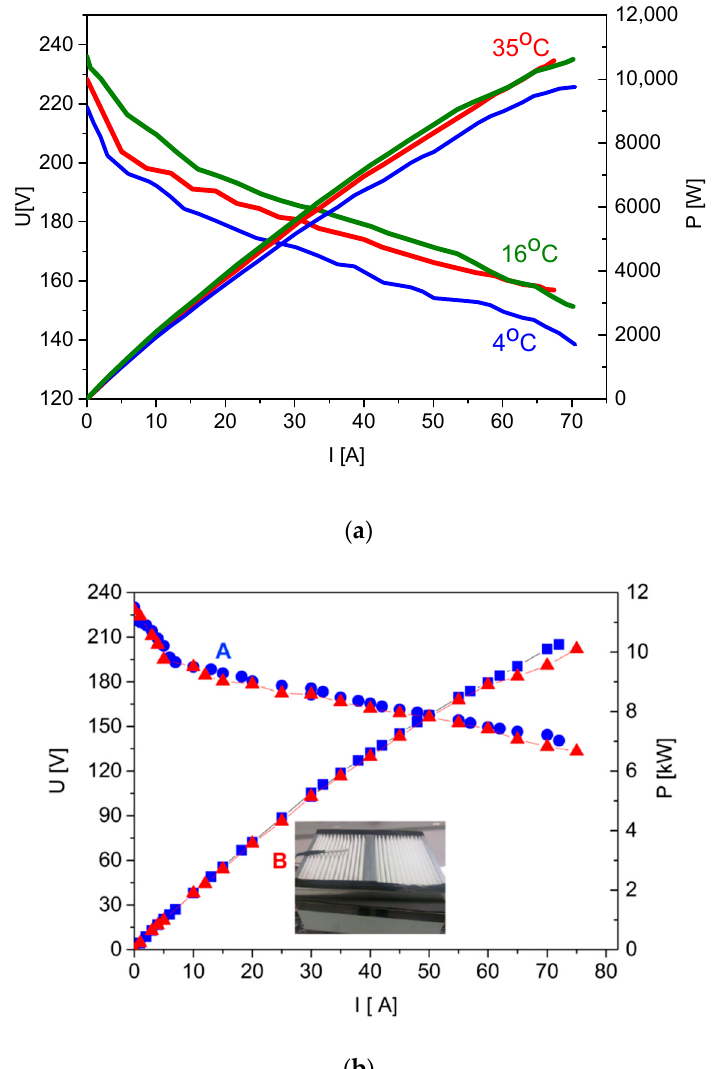
Figure 9. ( a ) Voltage U-current I or power P-current I dependencies recorded for a 10 kW PEMFC stack in different ambient conditions. The numbers above the curves denote the temperature (°C) of the performed measurements. ( b ) The U-I and P-I curves recorded for the PEMFC fuel cell stack operating freely in laboratory conditions (A) and in conditions with limited air inlet (B).